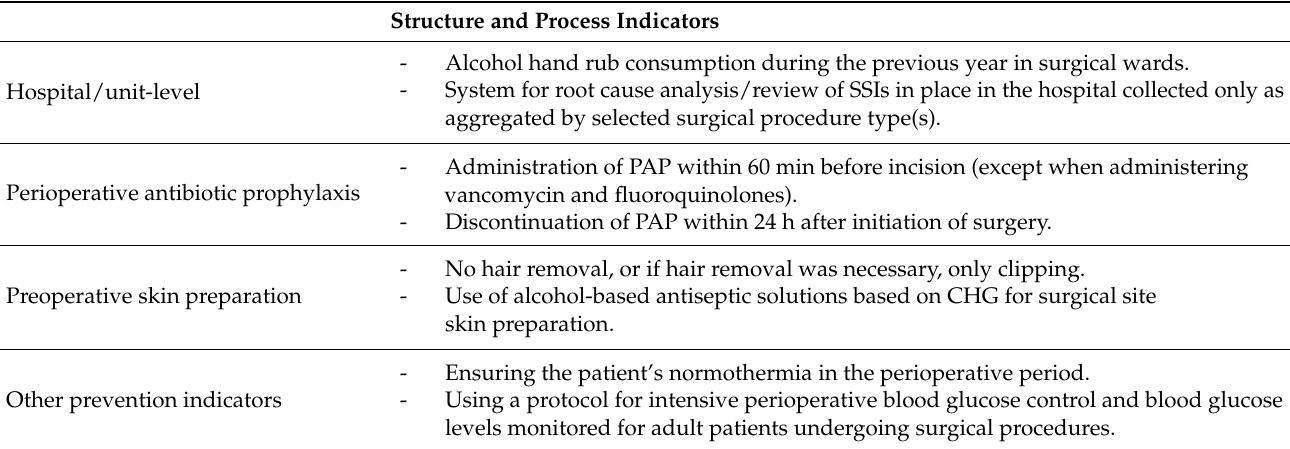
Table 2. Structure and process indicators for SSI prevention [75]. Structure and Process Indicators